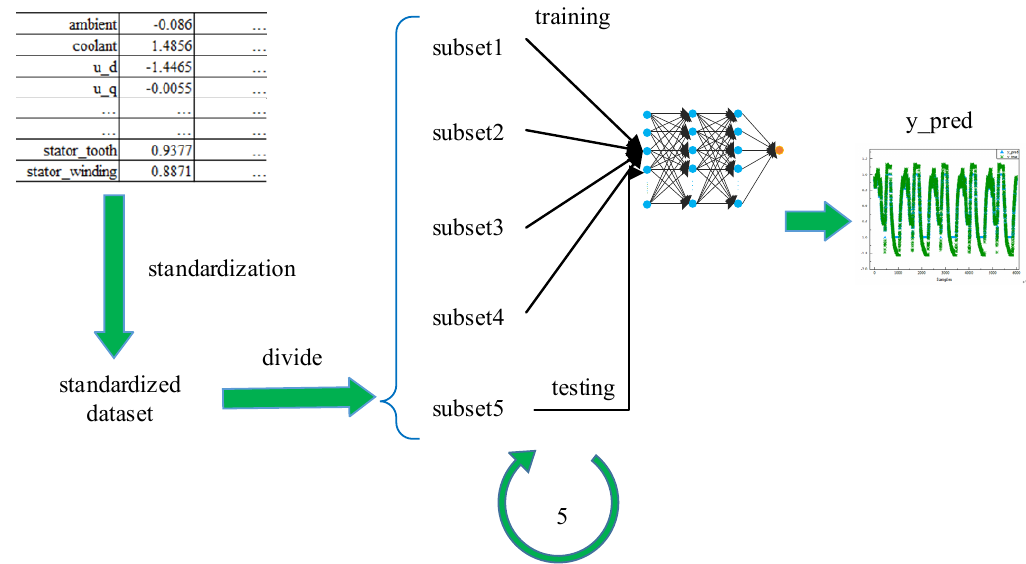
Figure 4. The process of predicting the PMSM stator winding temperature.